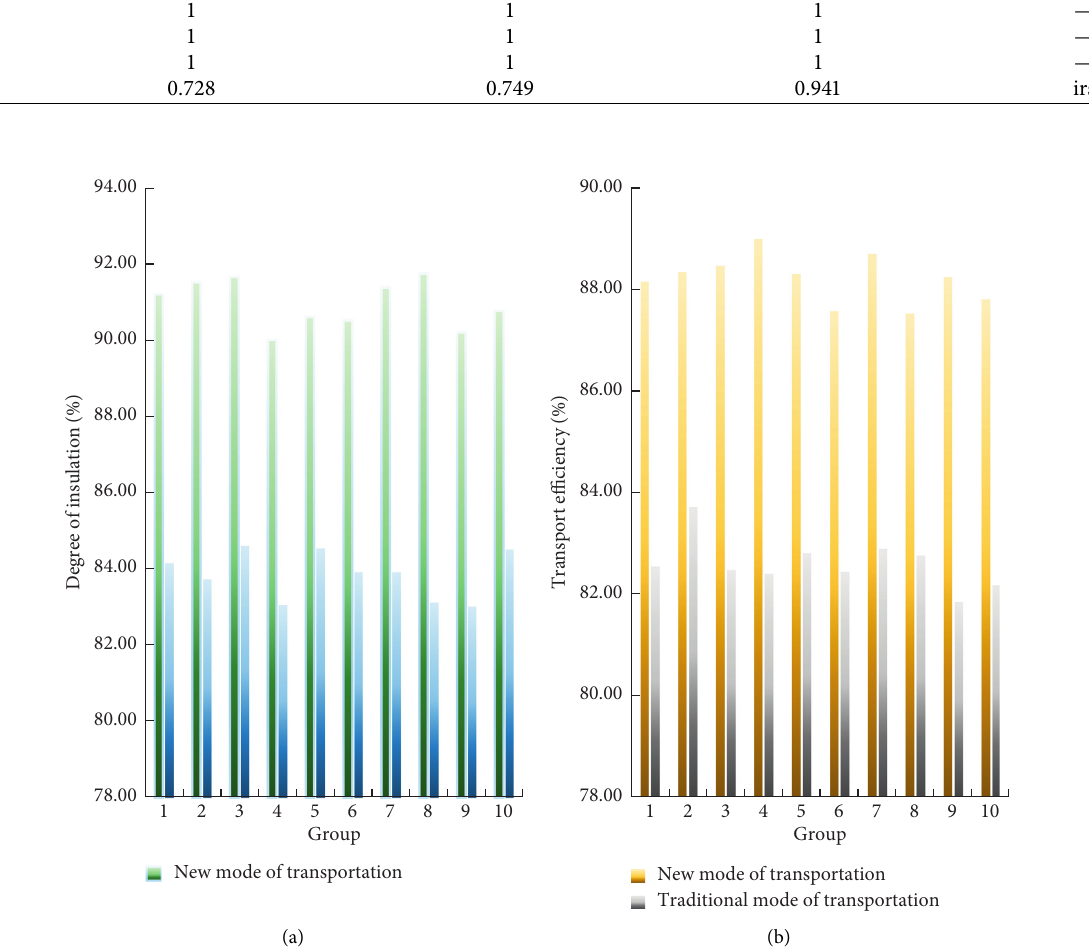
Figure 10: Comparison of experimental results. (a) Insulation degree comparison. (b) Transportation efficiency